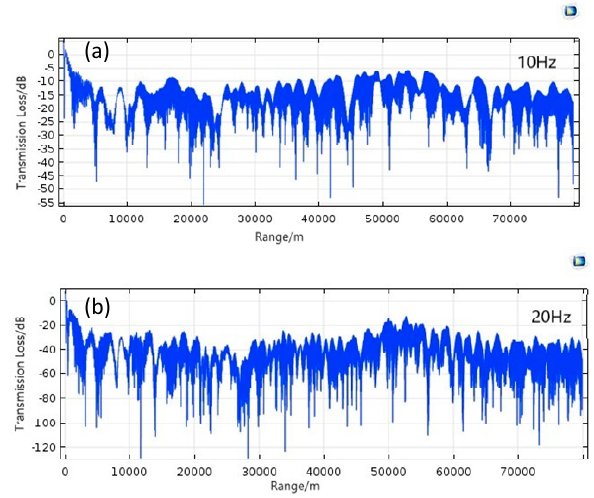
Figure 17. Sound transmission loss at different frequencies, ( a ) f = 10 Hz, ( b ) f = 20 Hz, depth 400 m (COMSOL model).